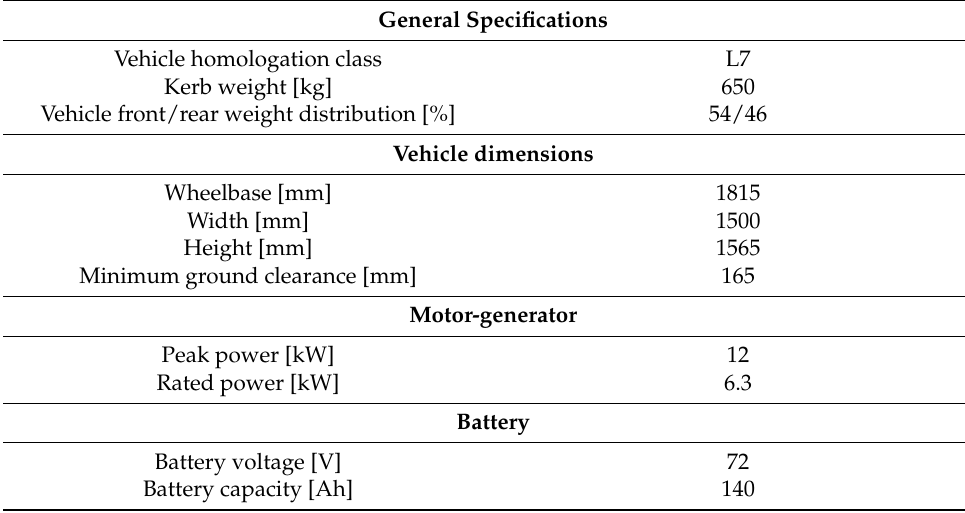
Table 2. Vehicle technical